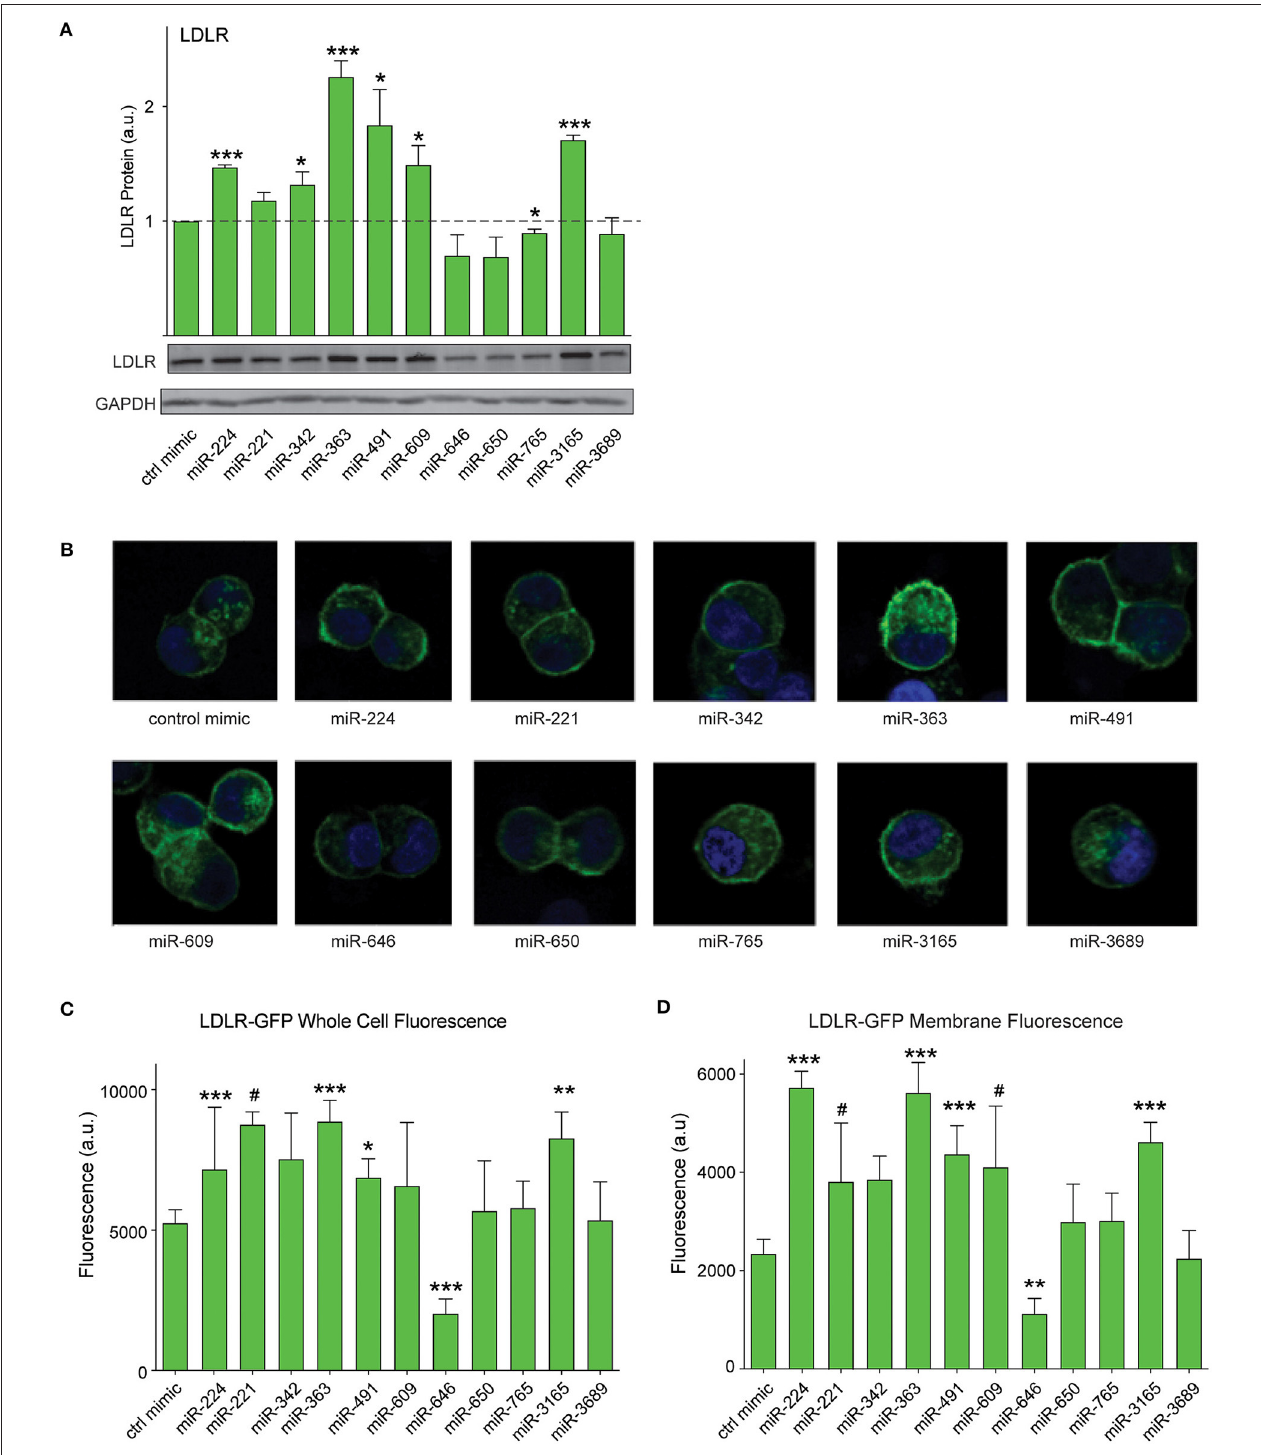
FIGURE 5 | PCSK9-targeting miRNAs regulate hepatic low-density lipoprotein receptor (LDLR) expression. (A) Western blotting analysis of LDLR and GAPDH protein in HepG2 cells transfected with miRNA mimics or a control mimic. Relative quantification of three independent experiments (mean ± standard error of the mean) is shown above the blots. (B) Representative fluorescent images of HepG2 cells stably expressing LDLR-GFP (green) transfected with miRNAs mimics or a control miR mimic. Counterstaining with DAPI to visualize nucleus (blue). (C,D) Quantification of (C) whole cell or (D) cell surface LDLR-GFP fluorescence intensity in HepG2 cells transfected with miRNA mimics or a control miR mimic. Data are representative of three independent experiments. p -Values were calculated using two-tailed Student’s t -test. # p < 0.1, * p < 0.05, ** p < 0.01, *** p < 0.001.